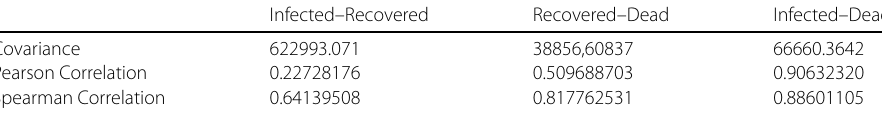
Infected–Recovered Recovered–Dead Infected–Dead